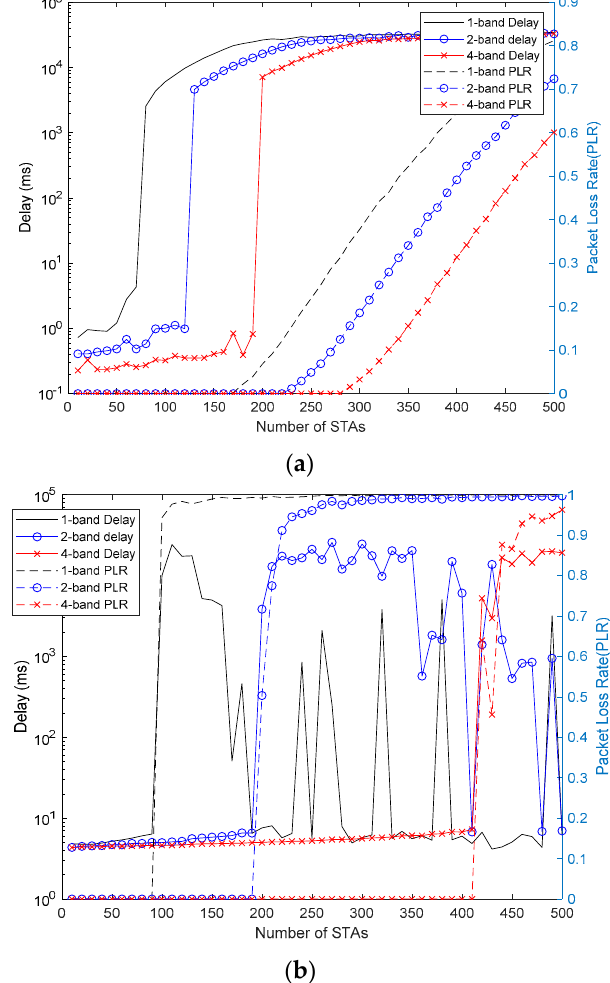
Figure 13. Overall average delay and PLR: ( a ) Conventional IEEE 802.11p channel access scenarios; ( b ) Proposed V2X-UORA channel access scenarios.